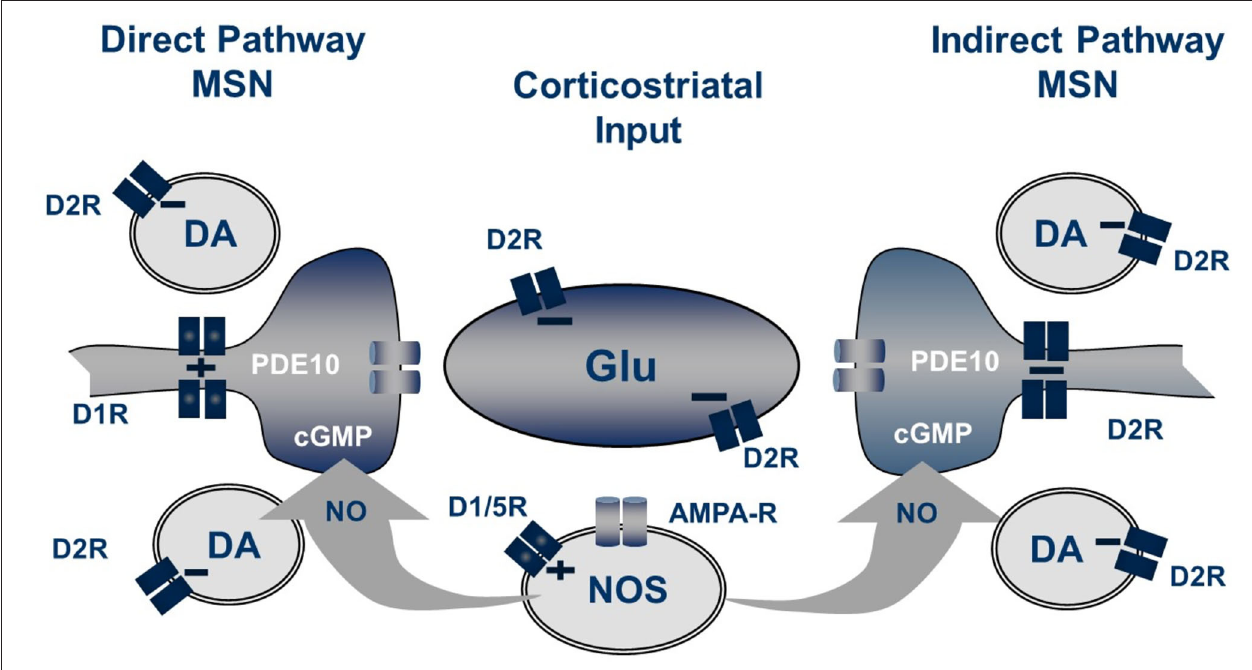
FIGURE 2 | Striatal regulation of cGMP signaling in direct and indirect pathway MSNs. The generation of NO from NOS + interneurons is dependent upon both D1-like receptors and glutamate acting on AMPA receptors while the concentration of cGMP in MSN is regulated by phosphodiesterase activities including PDE10A. Not shown are the cholinergic interneurons which also play a role in this